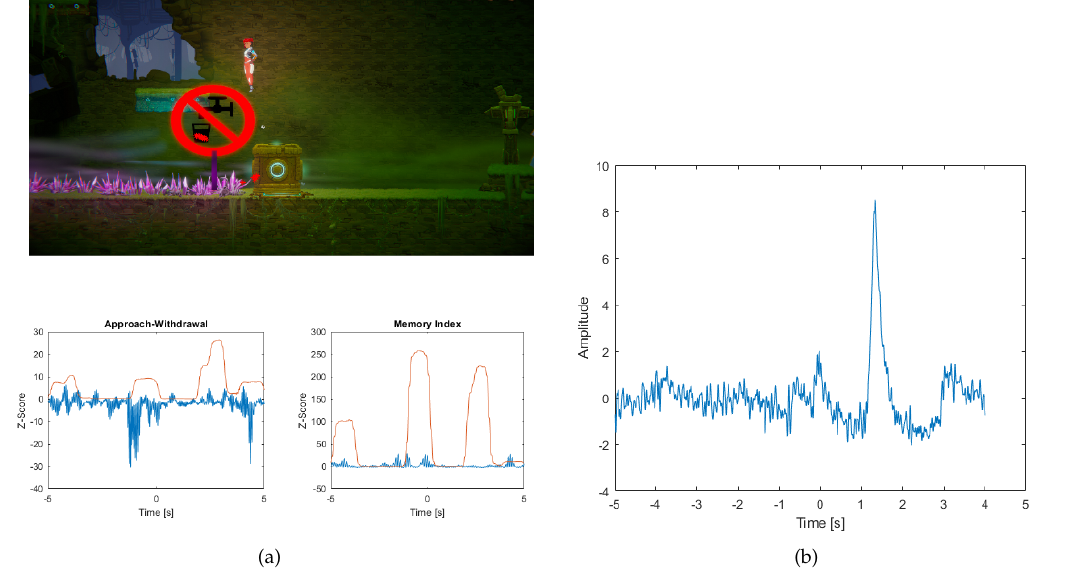
Figure 13. ( a ) The picture shows a screenshot of the game, where the player overcomes an obstacle that is spikes. In the picture, the points where the player is looking are marked with red stars. Below are the graphs (blue) of the Approach-Withdrawal and Memory Index and the standard deviation value for both indices (red line) ( b ) A graph showing the occurrence of an ocular artifact after an obstacle